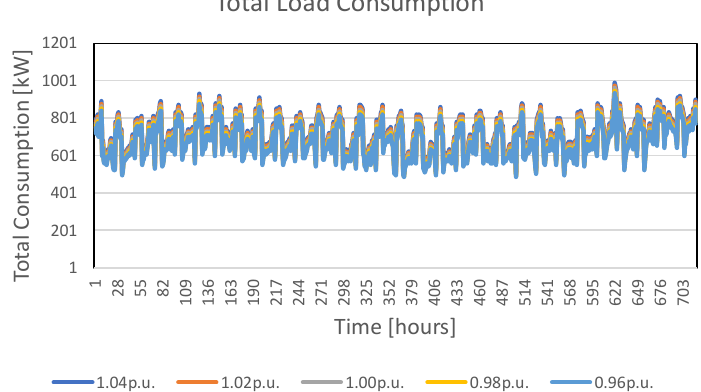
Figure 6. Total load consumption in June for different CVR setpoints on an hourly basis.